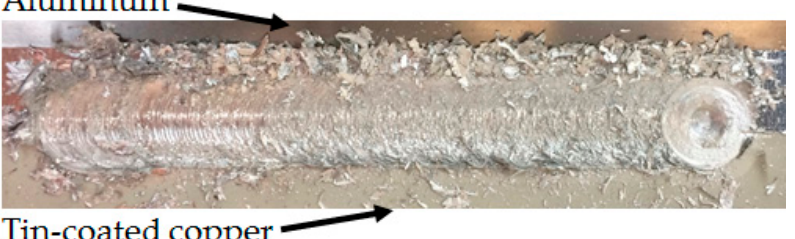
Figure 4 . Documentation of chip formation when welding aluminum with tinned copper .